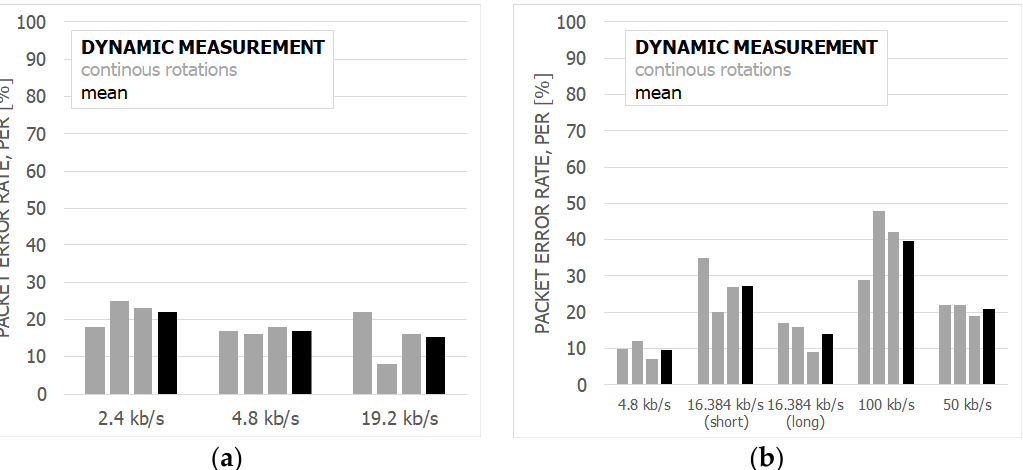
Figure 11. Packet Error Rate measurements for Wireless M-Bus obtained in the LKE (WUST) reverberation chamber: ( a ) dynamic measurements at 169 MHz, ( b ) dynamic measurements at 868 MHz.